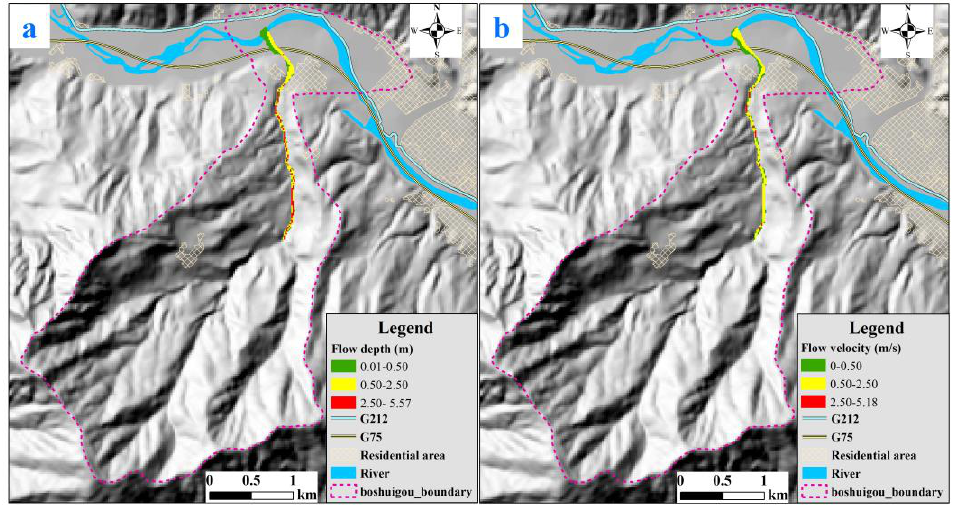
Figure 7. Flow depth ( a ) and flow velocity ( b ) of the Boshuigou debris flow under the 50-year return-period rainfall.